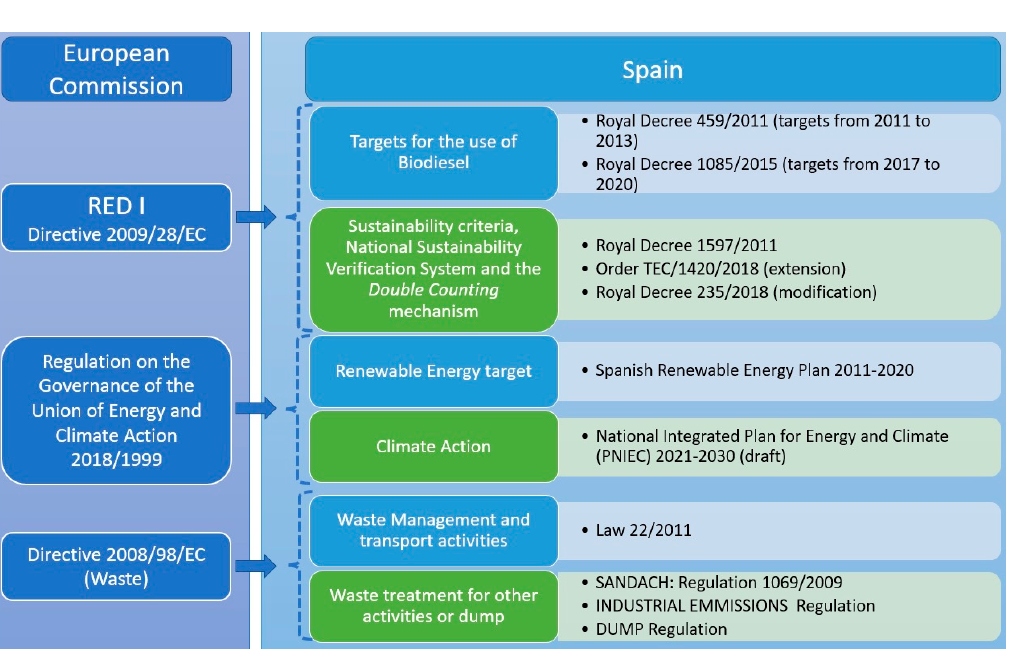
Figure 1. European Union (EU) regulation transposed into Spanish legislation. EC stands for European Commission, and RED for Renewable Energy Directive.